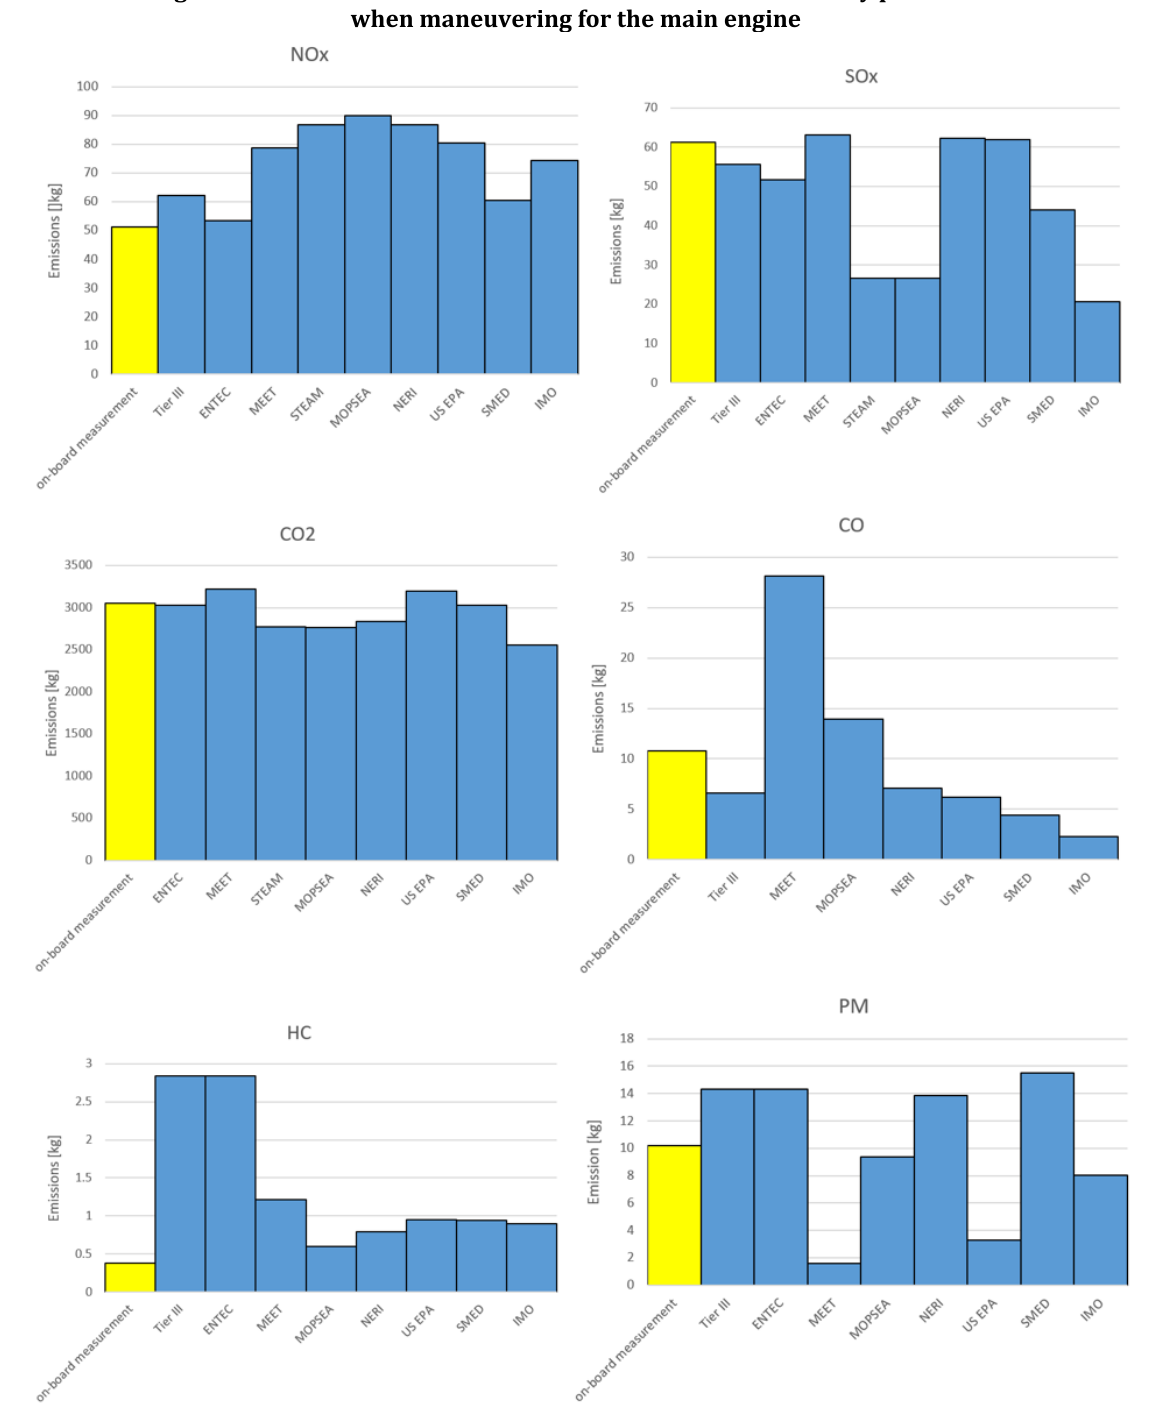
Figure 4: Total emission amounts’ measurement and inventory prediction when maneuvering for the main